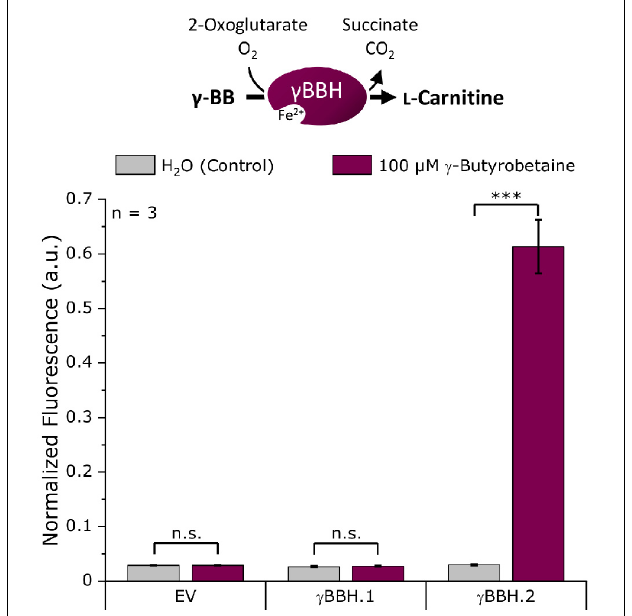
FIGURE 3 | TMABADH activities in crude extracts of E. coli DH5 α transformed with pECXT99A derivatives expressing potential TMABADH from N. crassa . TMABADH.1S and TMABADH.1 were derived from NCU00378, and TMABADH.2 was derived from NCU03415. pECXT99A was used as the empty vector control (EV). Means of three replicates are shown. Error bars were calculated by error analysis from the standard deviations of the enzyme assays and Bradford